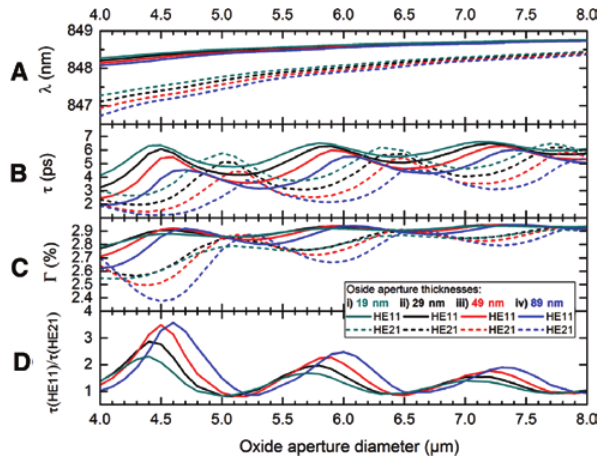
Figure 10: Simulation of the (A) wavelength, (B) lifetime, (C) confinement factor, and (D) lifetime ratio of the fundamental mode and the first excited modes of a leaky VCSEL with four different oxide aperture thicknesses: (i) 19 nm, (ii) 29 nm, (iii) 49 nm, and (iv) 89